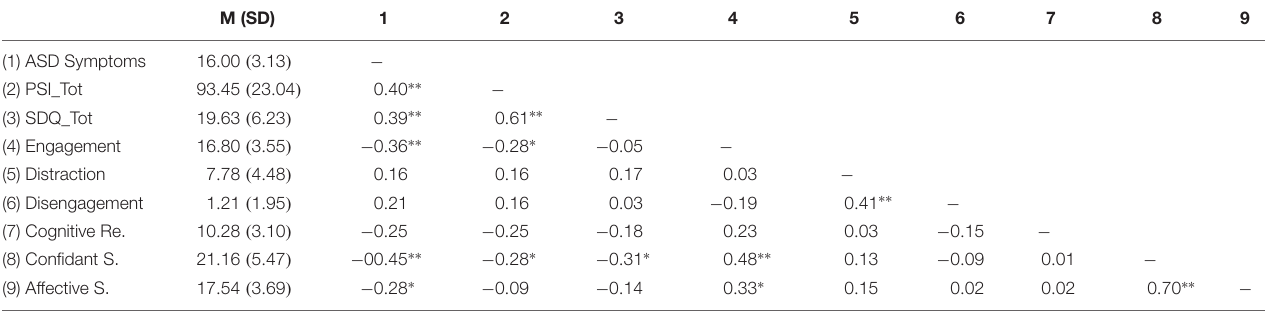
TABLE 2 | Pearson correlations between ASD symptoms, PSI, SDQ, coping skills, and social support. M (SD)